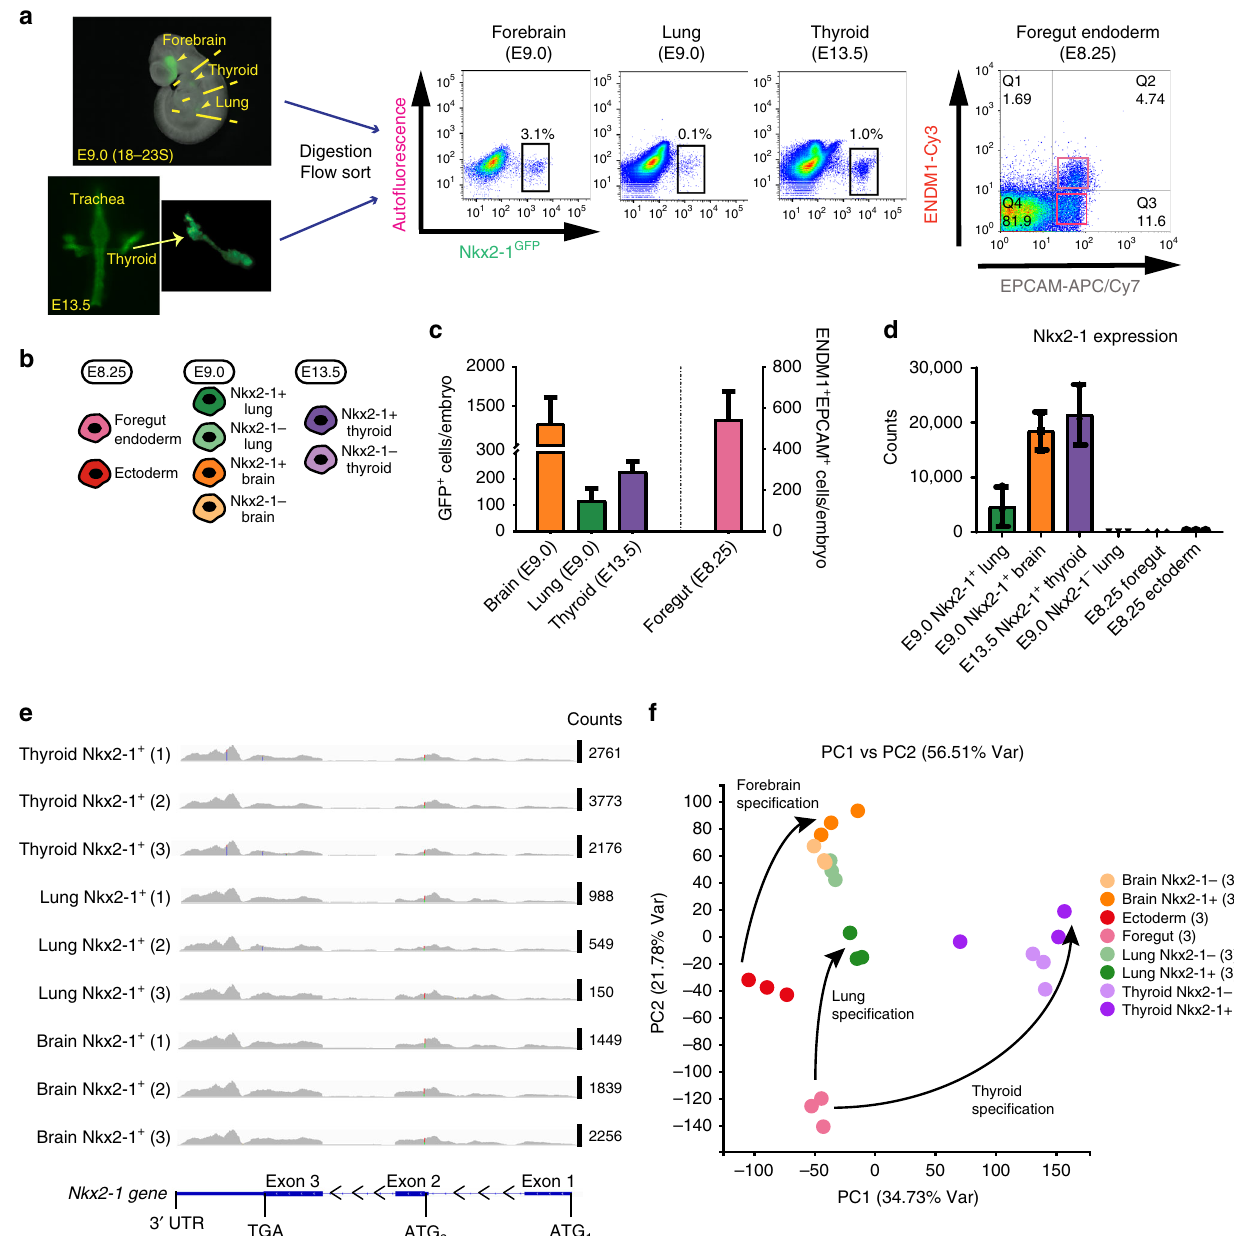
Fig. 2 RNA-Seq analysis of puri fi ed mouse embryonic Nkx2-1 + populations. a Schematic of embryo dissection and NKX2-1 GFP + cell sorting at the lung primordium stage (E9.0, 18 – 23 somites) and at E13.5. The Nkx2-1 GFP + lung, thyroid, and forebrain domains were micro-dissected using an epi fl uorescence stereomicroscope. At E13.5, thyroid is separated from the trachea prior to enzyme digestion and sorting (left panels). Bivariate fl ow cytometry dot plots showing sorted NKX2-1 GFP + cell populations (middle panel) and pre-speci fi ed foregut endoderm (ENDM1 + EPCAM + ) and ectoderm (ENDM1 − EPCAM + ) (right panel). b FACS-puri fi ed cell populations used in RNA-Seq analysis. The same colors are consistently used in subsequent fi gures to identify the respective populations. c The number of cells recovered by fl ow cytometry and normalized per embryo for the NKX2-1 GFP + populations (lung, thyroid, and forebrain) and foregut endoderm. The number of sorts: N = 7 for the lung, thyroid, and forebrain; N = 5 for foregut endoderm, error bars represent standard deviation. d Nkx2-1 expression (RNA-Seq normalized counts) in sorted Nkx2-1 GFP + and Nkx2-1 GFP -negative populations. e Nkx2-1 counts for all Nkx2-1 GFP + samples ( N = 3 lung, thyroid, and forebrain samples) mapped on the Nkx2-1 locus. Normalized Nkx2- 1 counts for each sample are indicated on the right. f Principal component analysis (PCA) plot of the eight populations depicted in ( b ). Arrows connect speci fi ed endodermal or ectodermal populations and their respective precursor stages. The partial overlap of the Nkx2-1 − lung and forebrain fi eld populations is most probably due to the fact that both populations are heterogeneous and contain mesenchymal, endothelial, neuronal, non-lung foregut, and other This analysis demonstrates the distinct genetic programs of (Fig. 3a) and that have also been identi fi ed by us as part of the Nkx2-1 + developing lineages and how these programs temporally transcriptional signature of in vitro human PSC-derived NKX2- 1 GFP + putative forebrain progenitors 20 . differ from cells within each relevant germ layer.